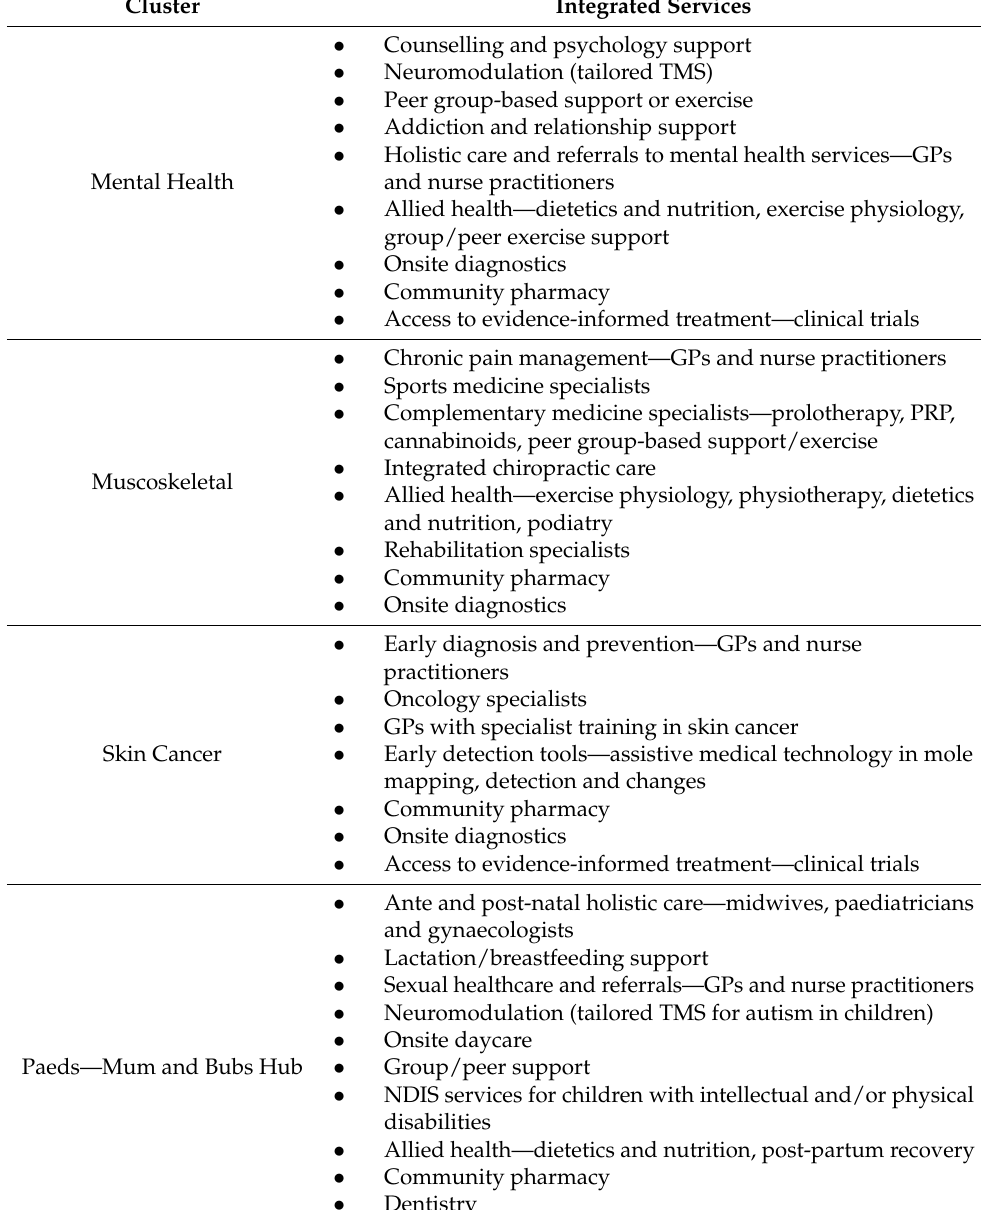
Table 1. Morayfield health precinct cluster